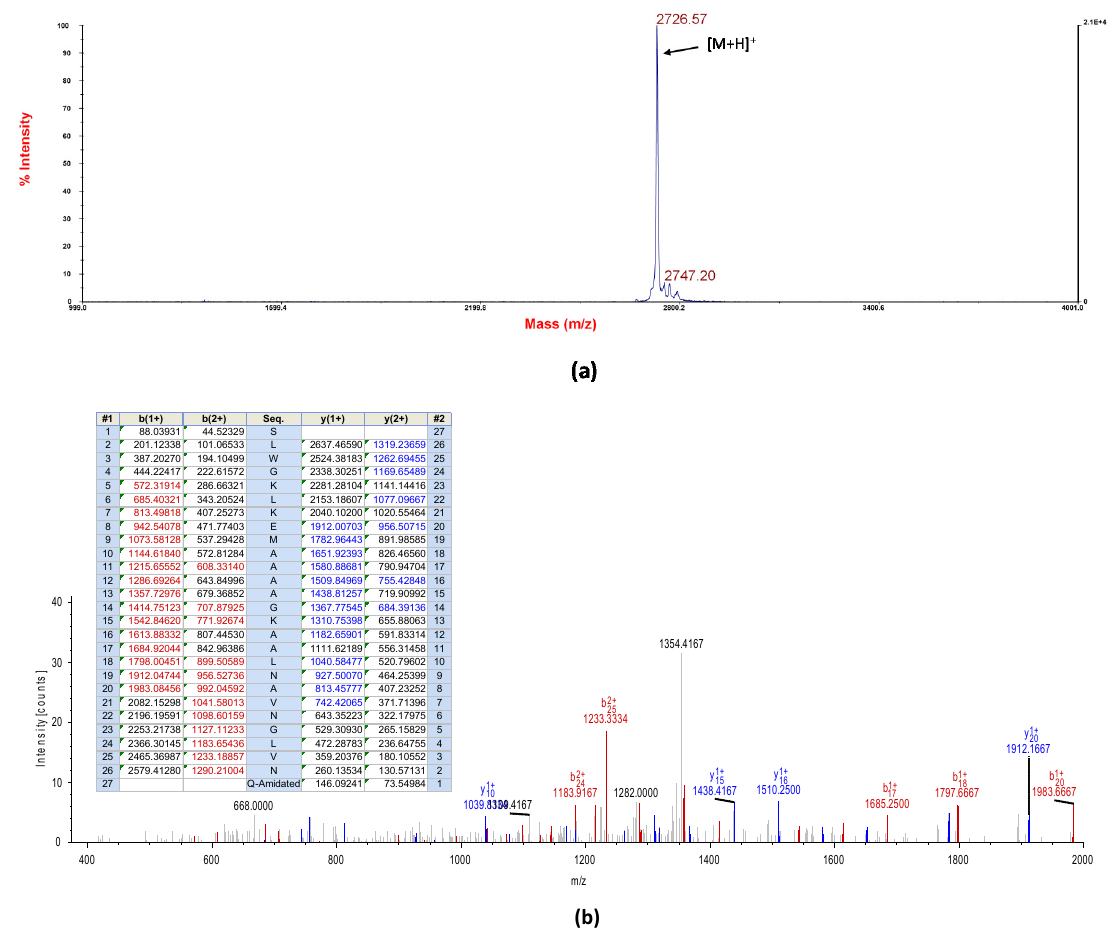
Figure 4. Mass spectra of DRP-AC4 isolated from frog skin secretion. ( a ) MALDI-TOF spectrum of the HPLC fraction at 126 min in Figure 3 corresponding to DRP-AC4; ( b ) Annotated MS/MS fragmentation spectrum. Predicted b- and y-ion MS/MS fragment ion series (singly- and doubly-charged) arising from MS/MS fragmentation. Observed ions are shown in coloured typeface.